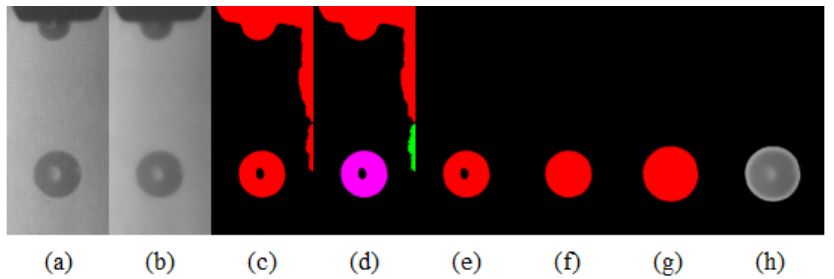
Figure 8. Image preprocessing flow chart.